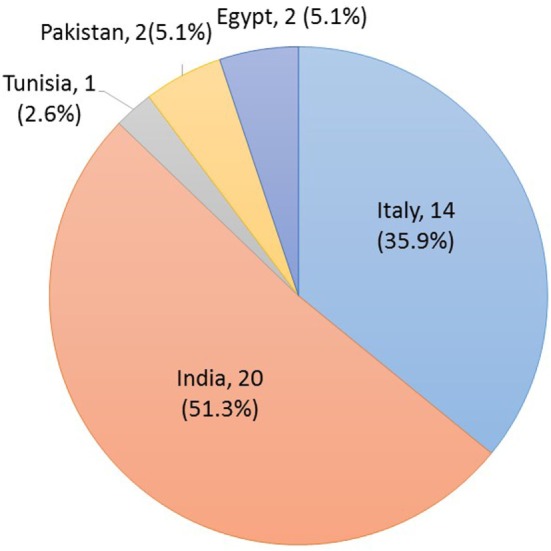
Distribution of country of origin for the Italian dairy subjects.